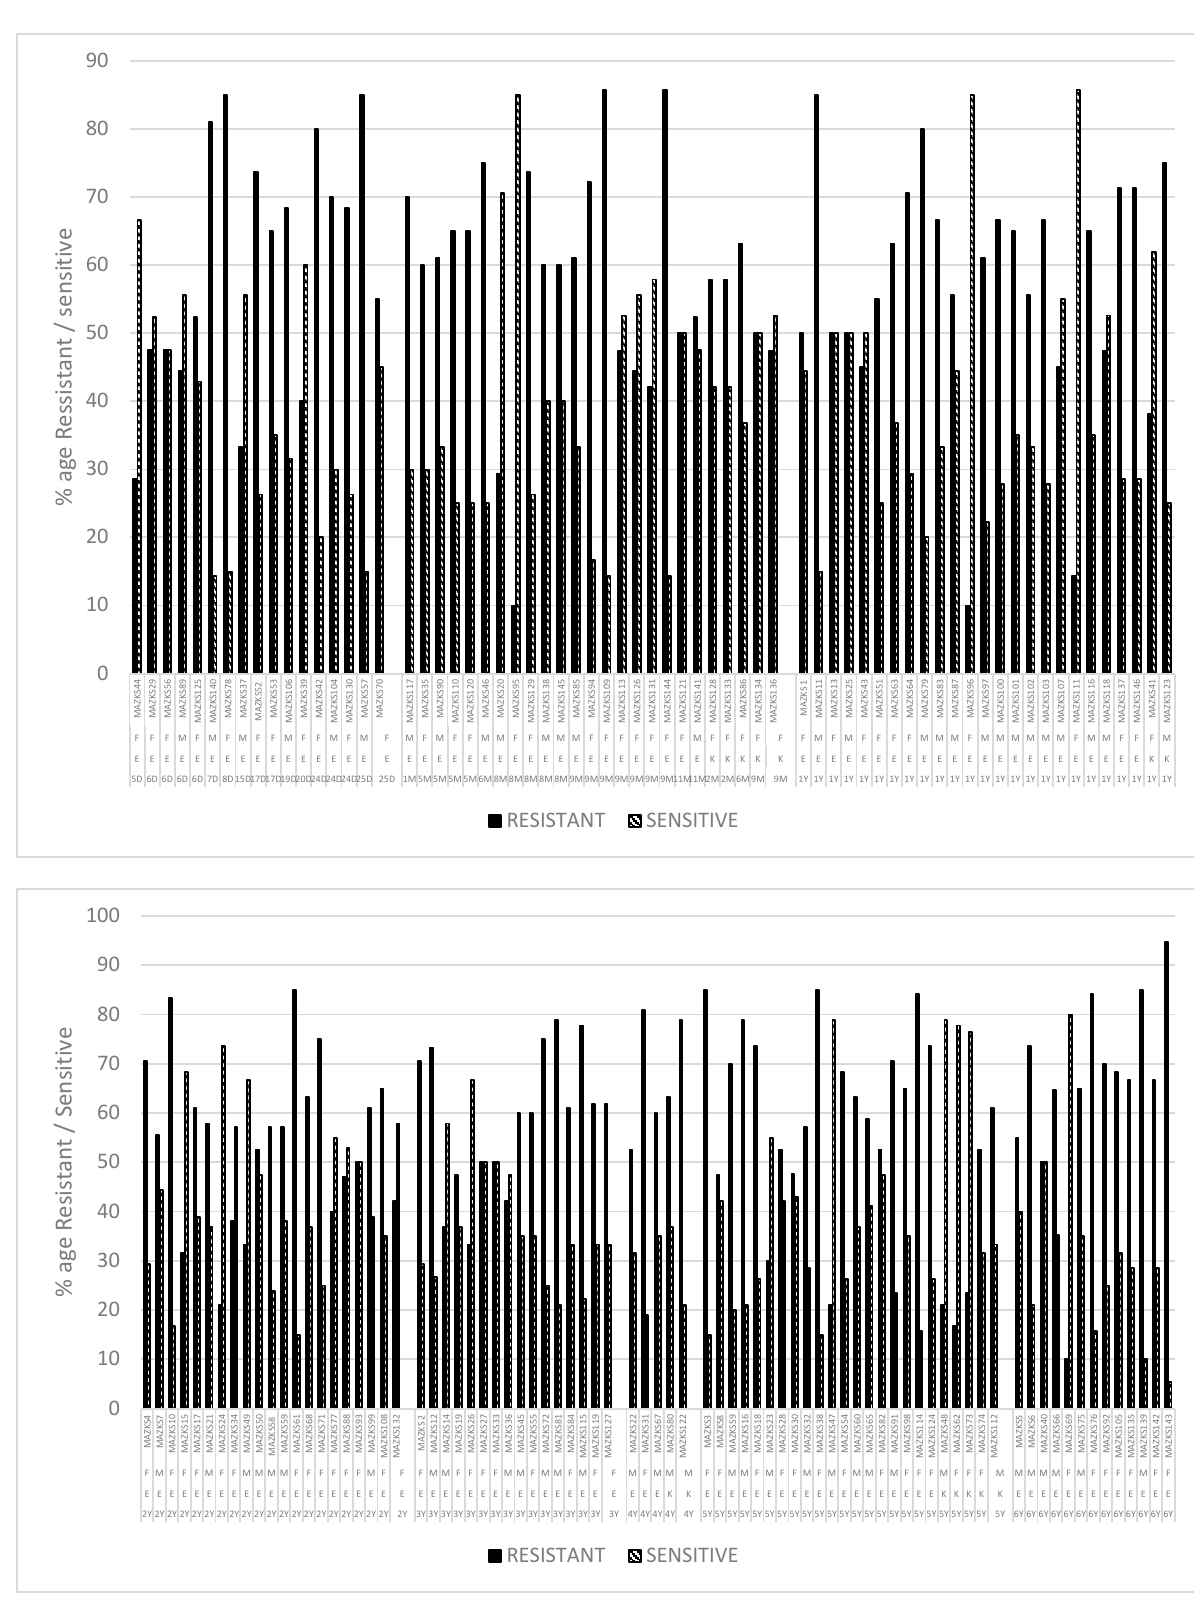
Figure 6. Percentage of antibiotic resistance/sensitivity (against tested antibiotics) in Escherichia and Klebsiella in relation to age and gender from pediatric patients’ (aged 0–6 years) samples at Shaikh Zayed. E = Escherichia ; K = Klebsiella ; F = Female; M = Male; M = Age in Months, Y = Age in years (1 Year, 2 Years, 3 Years, 4 Years, 5 Years, 6 Years) .